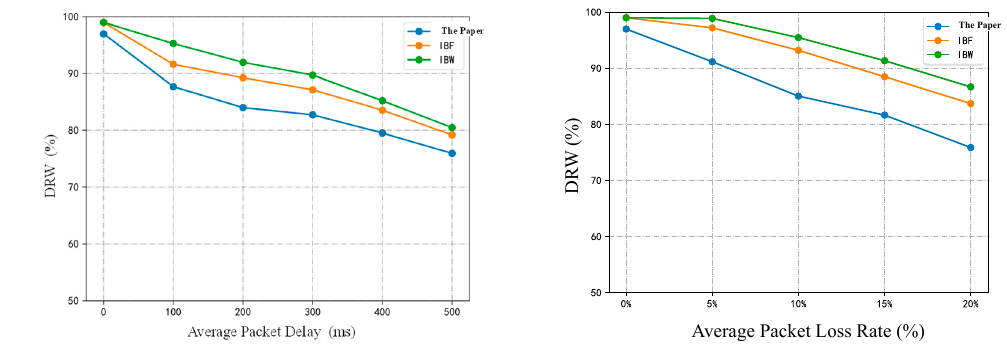
Figure 9. The DRW in different packet delays and packet loss rates.